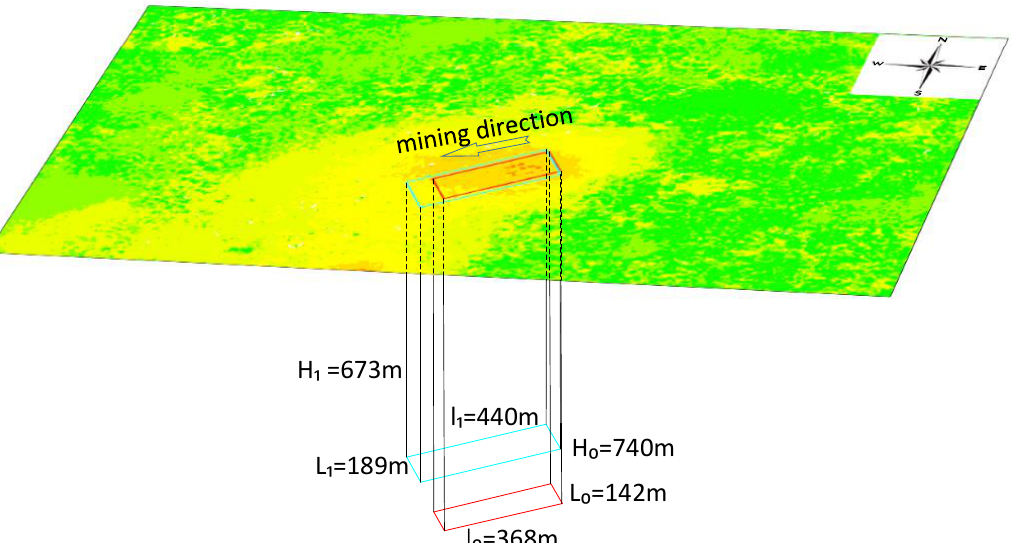
Figure 12. Comparison of locating results and actual position of the working face. The blue rectangle represents the real position of the goaf, and the red rectangle represents the calculated position of the goaf. H 0 , l 0 , and L 0 are the depth, length, and width of the real goaf; H 1 , l 1 , and L 1 are the depth, length, and width of the calculated goaf.